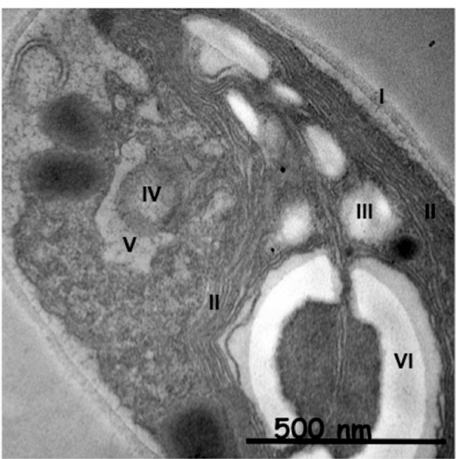
Figure 7. TEM micrograph of Chlorella vulgaris ultrastructure in Seine river water: (I) Cell membrane, (II) thylakoids, (III) paramylon vesicle, (IV) nucleus, (V) nuclear membrane, (VI)